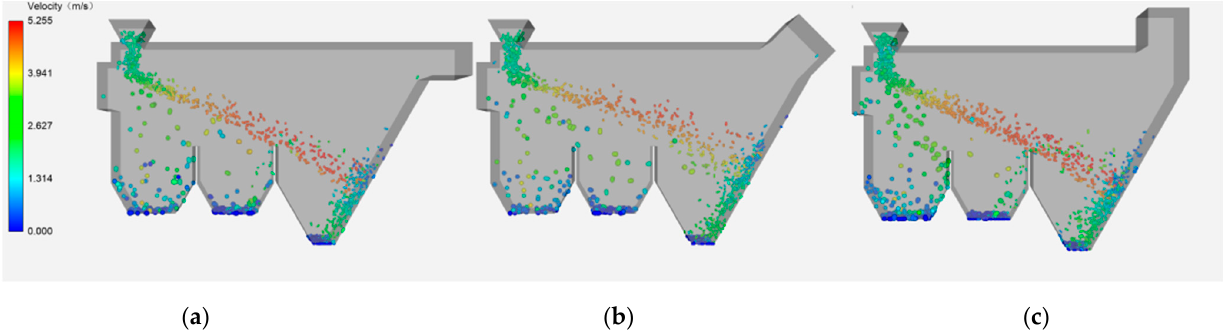
Figure 18. Airflow velocity contour plots of different types of dust remover angles: ( a ) 0 ◦ ; ( b ) 45 ◦ ; ( c ) 90 ◦ . Figure 19. Particle motion of different types of dust remover angles: ( a ) 0°; ( b ) 45°; ( c ) 90°.